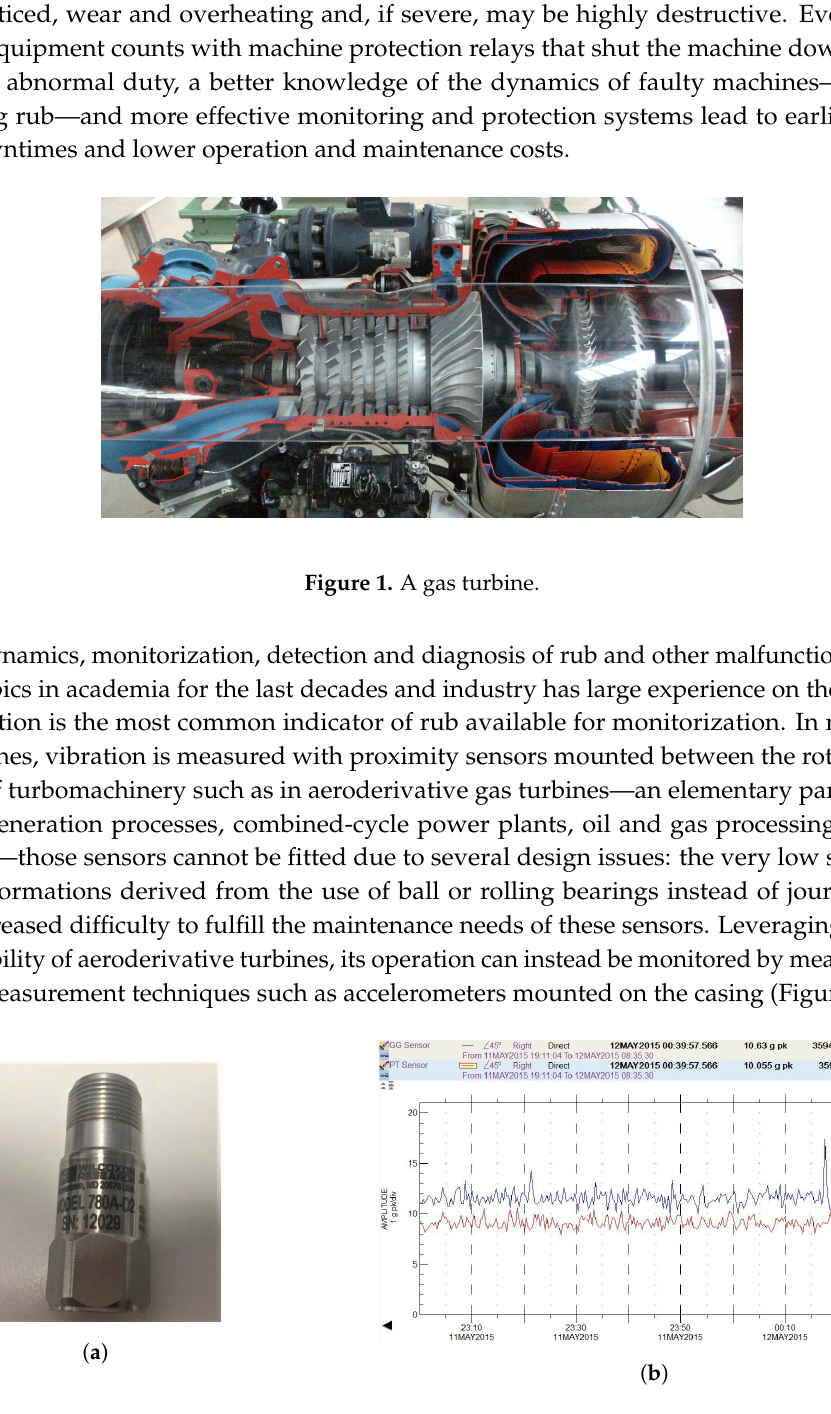
Figure 2. ( a ) A Wilkoxon 780A-D2 general purpose accelerometer for machine vibration monitoring; and ( b ) an accelerometer output representing acceleration as a function of time, in the ADRE monitoring system